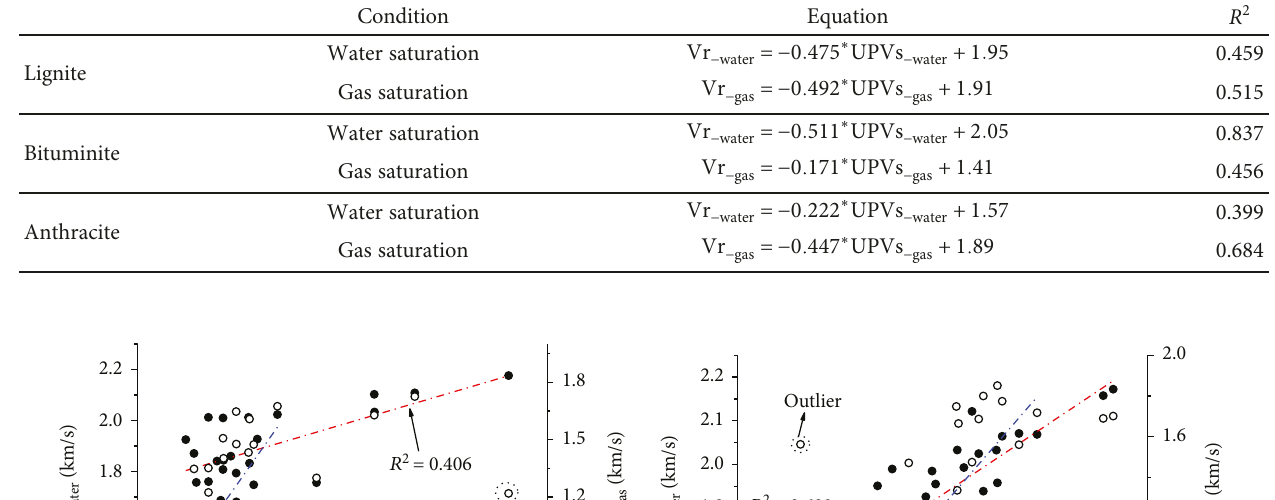
Table 4: Linear fi t equations of Vr for lignite, bituminite, and anthracite under water and gas saturation.